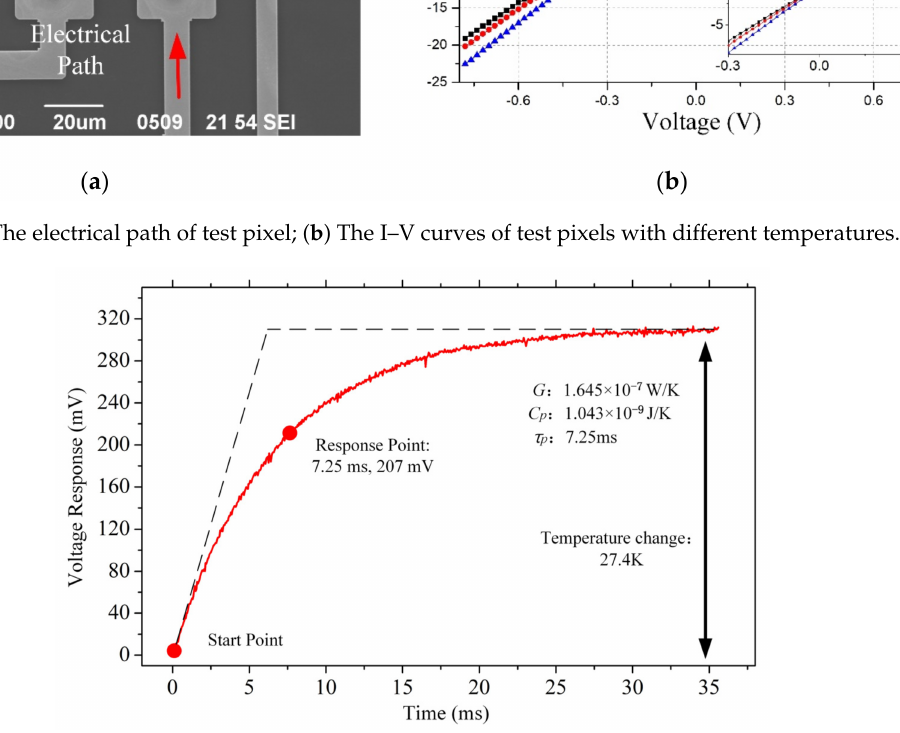
Figure 8. The test pixel thermal response curve of a micro-bolometer